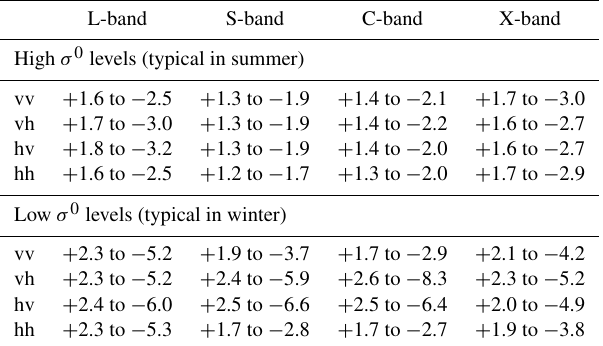
Table 2. Example uncertainty values (cid:49)σ 0 (dB) per bandwidth, po- larization, and overall σ 0